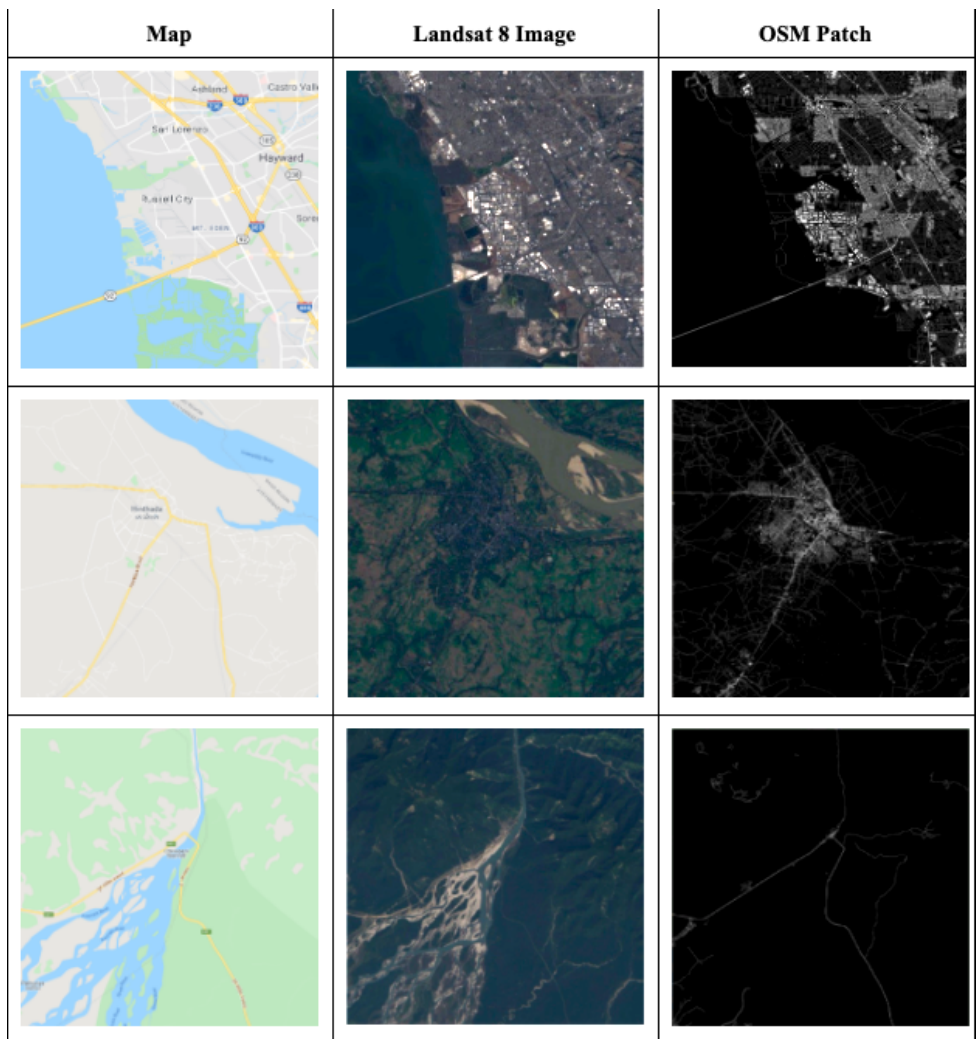
Figure 5. Example OSM patches generated for three different geographical areas (urban, semi-urban, and rural). Column 1 shows the image from Google Maps, column 2 shows the Landsat 8 true color image, and column 3 is the OSM